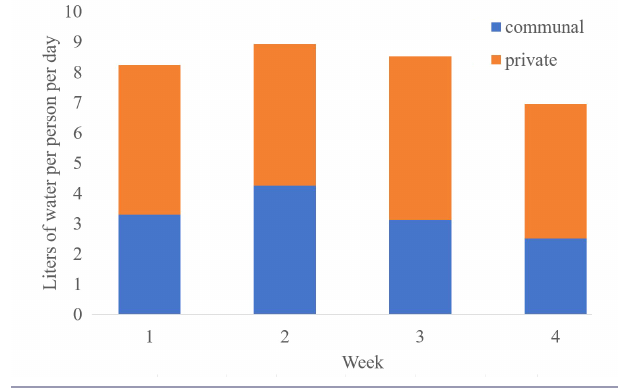
Fig. 5. Distribution of water use during each week of the experiment. Bars show the mean of the total amount of fresh water used (excluding grey water) per day per